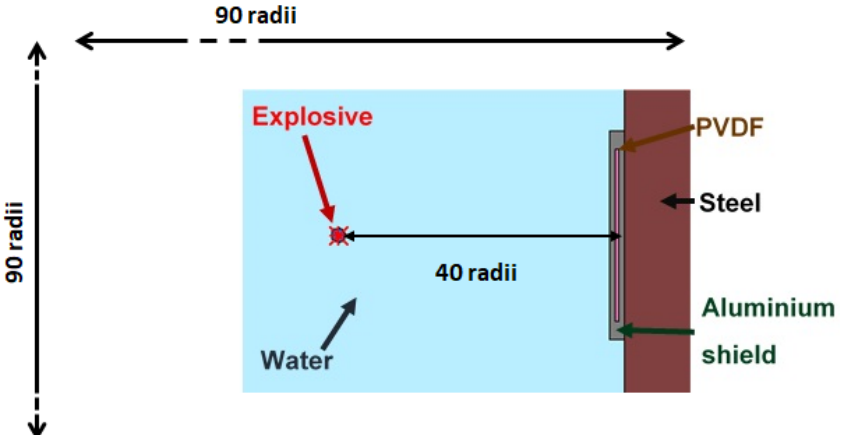
Figure 14. SPEED ® modelling of detonating cord underwater explosion above PVDF gauge placed on steel